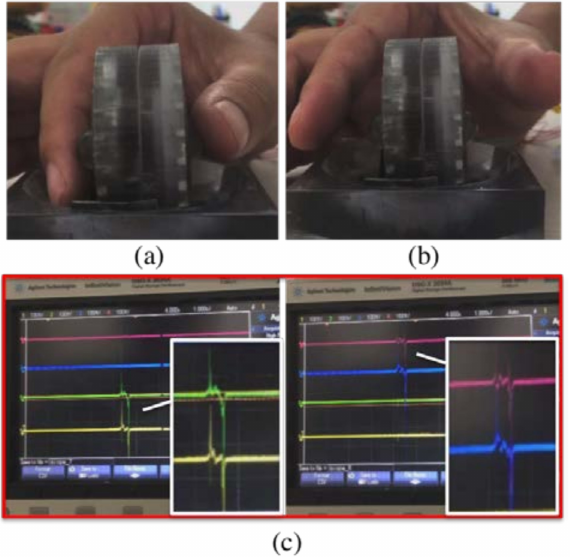
Figure 7. ( a ) Photograph of the thumb and index finger pressing the two spheres. ( b ) The two fingers releasing from the spheres. ( c ) The corresponding signals display on the